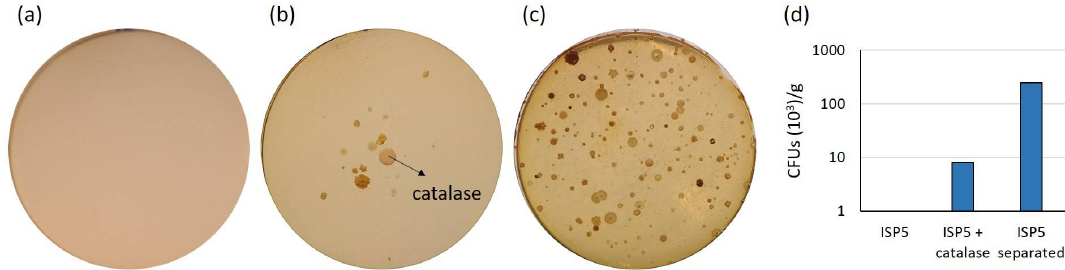
Figure 2. Effect of reactive oxygen species on bacterial growth in International Streptomyces Project (ISP) medium number 5 (ISP5) medium. Growth in ( a ) ISP5 medium prepared according to the standard protocol, in ( b ) the same medium but with catalase injected on the paper disc in the center of the plate, and in ( c ) the ISP5 medium prepared with autoclaving of agar and phosphate separate from the other media components. ( d ) CFUs on ( a ), ( b ) and ( c ).